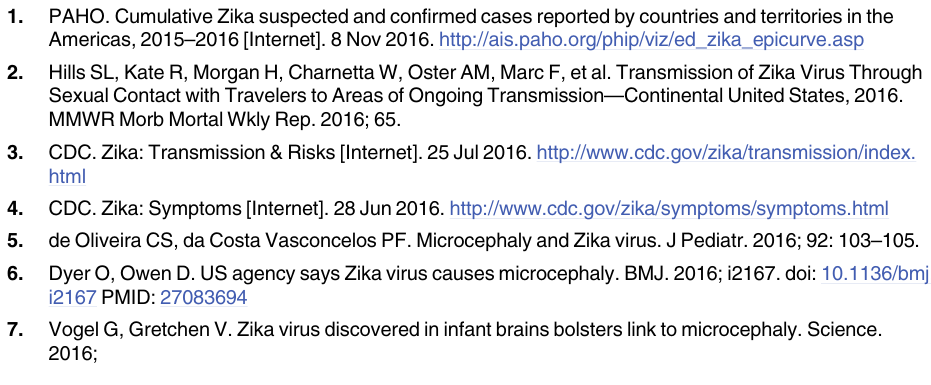
S1 Fig. Correlation of digital predictors with official suspected Zika case counts in (a) Colombia, (b) Honduras, (c) Venezuela, (d) El Salvador, and (e) Martinique. The transfor- mation that produced the highest correlation with Zika cases for each variable is shown in each plot. Data points from weeks within the training period are distinguished in red. S2 Fig. Heatmaps showing the relative influence (positive: red; negative: blue) of all input variables on predictions of Zika cases in (a) Colombia, (b) Honduras, (c) Venezuela, (d) El Salvador, and (e)